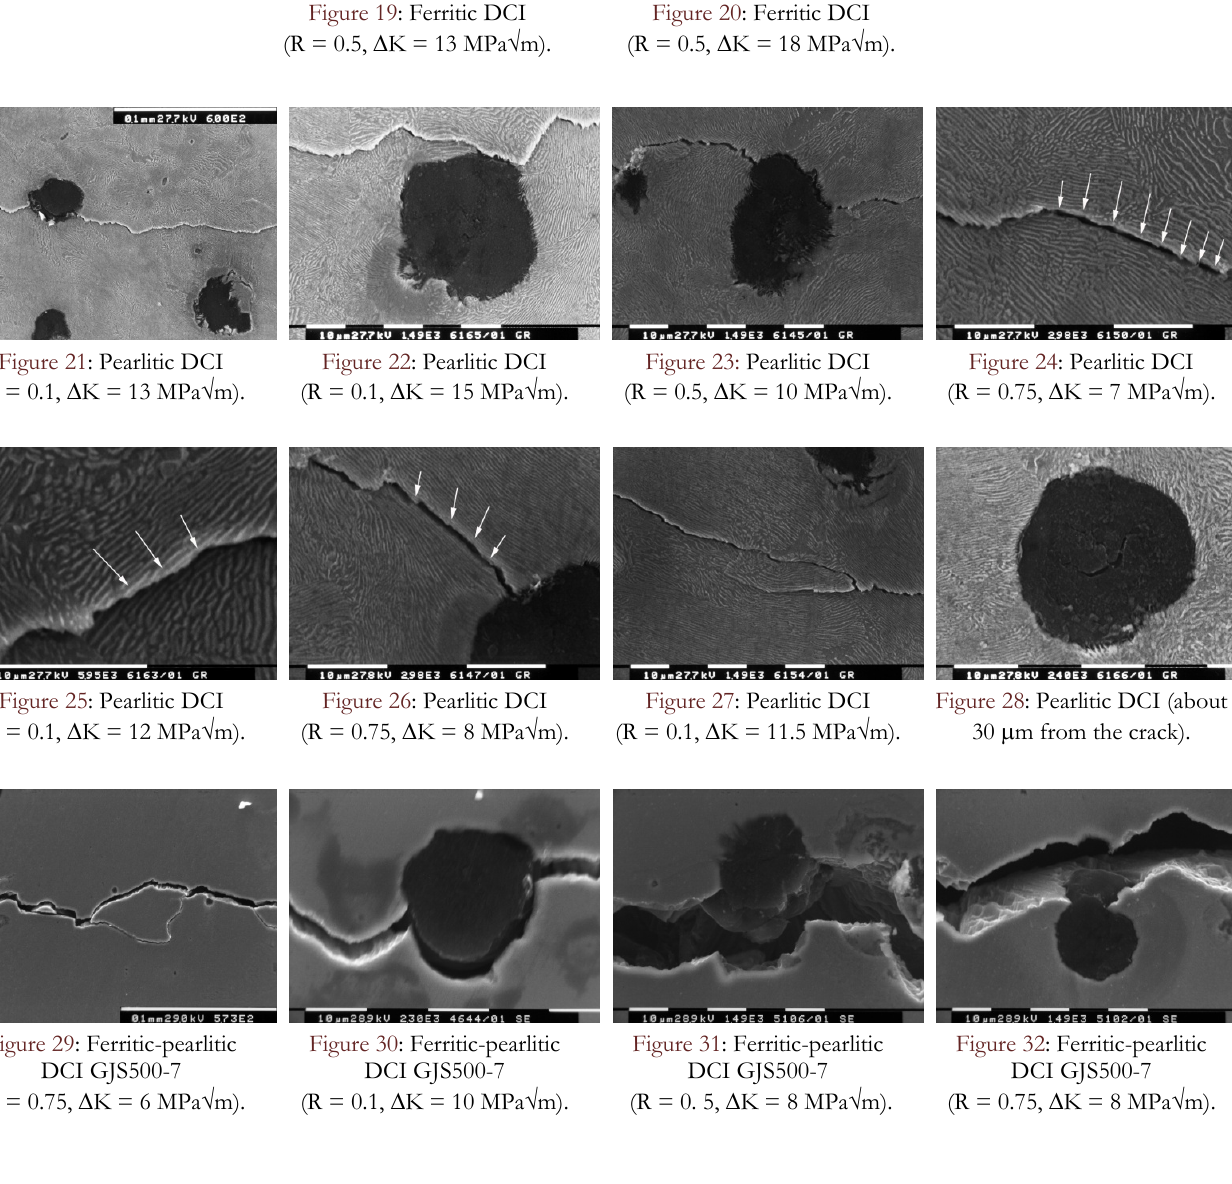
Figure 29: Ferritic-pearlitic DCI GJS500-7 (R = 0.75,  K = 6 MPa √ m).